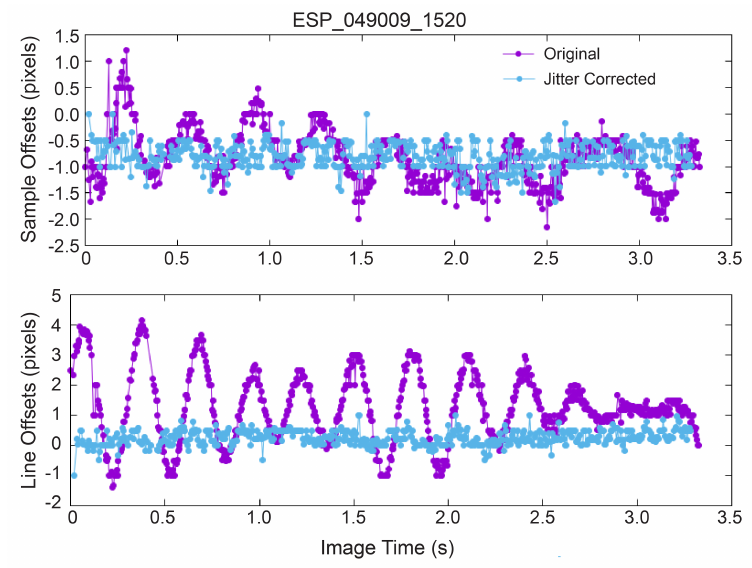
Figure 3. Plots of pixel offsets in the sample, or cross-track ( top ), and line, or along–track ( bottom ) directions, measured in the overlapping region of the RED4 and RED5 CCDs over the length of observation ESP_049009_1520. Before jitter correction (purple), pixel offsets show an amplitude of up to 4 px. After correction (light blue), offset amplitudes are reduced to ∼ 0.5 px in both the sample and line